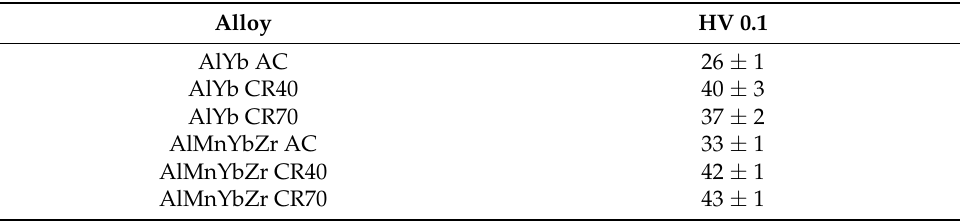
Table 1. Initial values of microhardness HV0.1 for the AlYb and AlMnYbZr as-cast (AC) and cold rolled alloys with reduction of 40% (CR40) and 70%